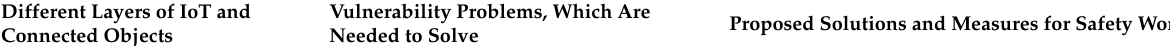
Table 2. The layers of IoT applicable for monitoring intermodal transportation